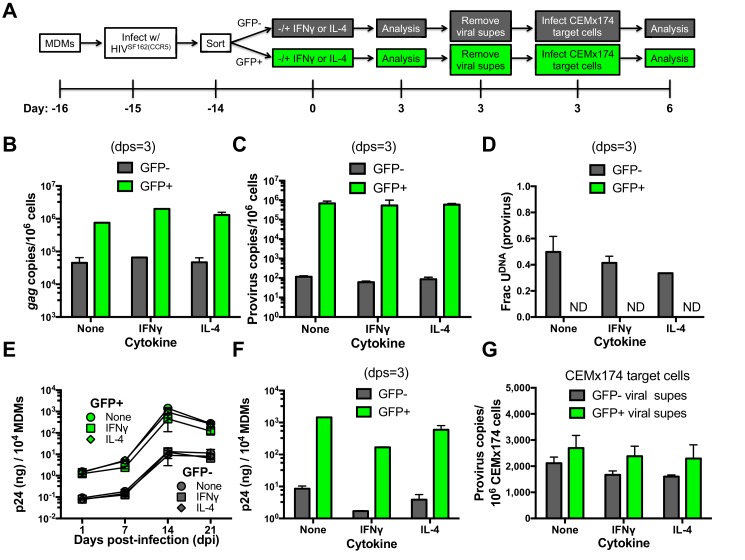
Effects of cytokine stimulation on viral transmission in GFP sorted MDM populations.(A) Experimental approach. (B) MDMs infected with HIVSF162(CCR5) were sorted into GFP+ (green bars) and GFP− (white bars) populations and analyzed with respect to gag copy number (dps; days post-stimulation). (C) Provirus copy numbers for each MDM population were measured using ALU-gag nested qPCR at 3 dps. (D) The fraction of proviral DNA copies containing uracil was measured using Ex-ALU-gag nested qPCR. ND; Not Detected. (E) Viral growth kinetics of sorted MDM populations. (F) Levels of virus in culture supernatants of GFP+ and GFP− MDM producer cells were measured using p24 ELISA. (G) Viral supernatants from each MDM treatment were normalized to p24 levels and used to infect naïve CEMx174 target cells. Provirus copies were measured using ALU-gag qPCR. The results are normalized to one million target cells. In all cases, the number of experimental replicates (n = 4–5) and errors are reported as mean ± SD.DOI:
http://dx.doi.org/10.7554/eLife.18447.01910.7554/eLife.18447.020Figure 6—source data 1.qPCR measurement of gag copies (Figure 6B), provirus copies (Figure 6C) and uracil content (Figure 6D) in GFP sorted and cytokine treated MDMs.Viral growth kinetics (Figure 6E) and total virus (Figure 6F) content in culture supernatants as monitored by p24 ELISA. Ex-ALU-gag qPCR measurement of provirus content in CEMx174 target cells.